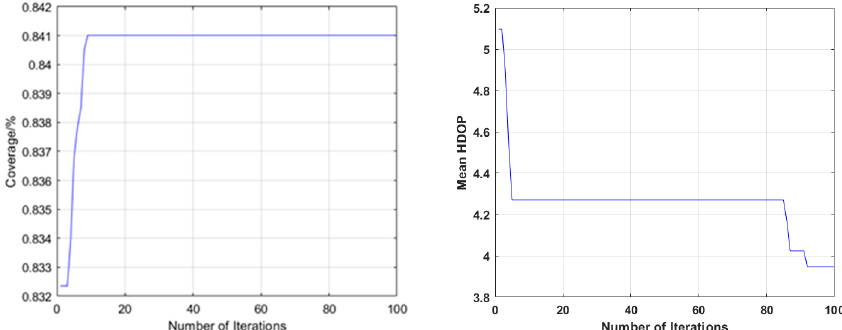
Figure 8. The convergence process of 16 pseudolite base stations optimized by Scheme 2 ( left ) and Scheme 3 ( right ).